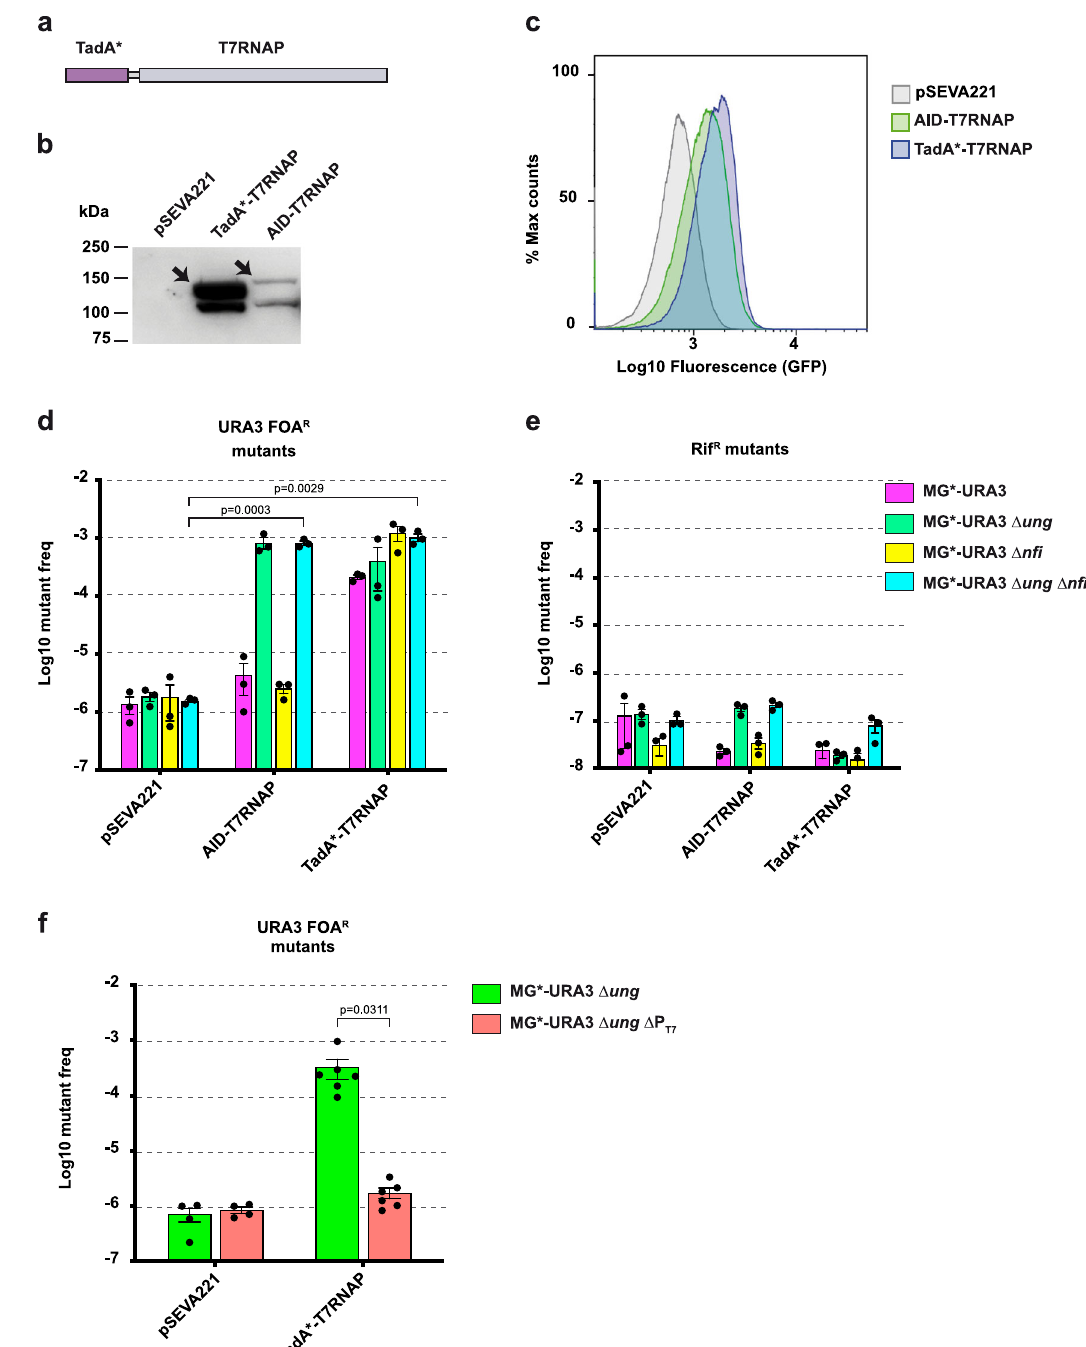
Fig. 3 Expression and activity of TadA*-T7RNAP. a Scheme of the fusion TadA*-T7RNAP with the linker (G 3 S) 7 . b Expression of the fusion TadA*- T7RNAP in comparison to AID-T7RNAP determined by western blot analysis of cell extracts from induced cultures. A representative immunoblot is shown from two independent experiments with similar results . c Processivity of the fusions assessed by fl ow cytometry analysis to detect expression of GFP in the induced cultures. The gating strategy and the corresponding pseudocolor plots are shown in Supplementary Fig. 3c. d , e Mutagenic activity of the AID- and TadA*-T7RNAP fusions in URA3 ( d ) and rpoB ( e ), using as hosts MG*-URA3, MG*-URA3 Δ ung , MG*-URA3 Δ n fi , and MG*-URA3 Δ ung Δ n fi ( n = 3 independent experiments). f URA3 mutant frequency when TadA*-T7RNAP is expressed in MG*-URA3 Δ ung and MG*-URA3 Δ ung Δ P T7 (pSEVA221 n = 4, TadA*-T7RNAP n = 6). The histograms ( d – f ) show the single values (black dots), the means (bars), and standard errors (lines) of multiple independent experiments. The statistical analysis was done using two-tailed Student ’ s t test. Exact p values ( p ) are indicated in the fi gure. A p value < 0.05 was considered signi fi cant. Source data are provided as a Source data fi le.